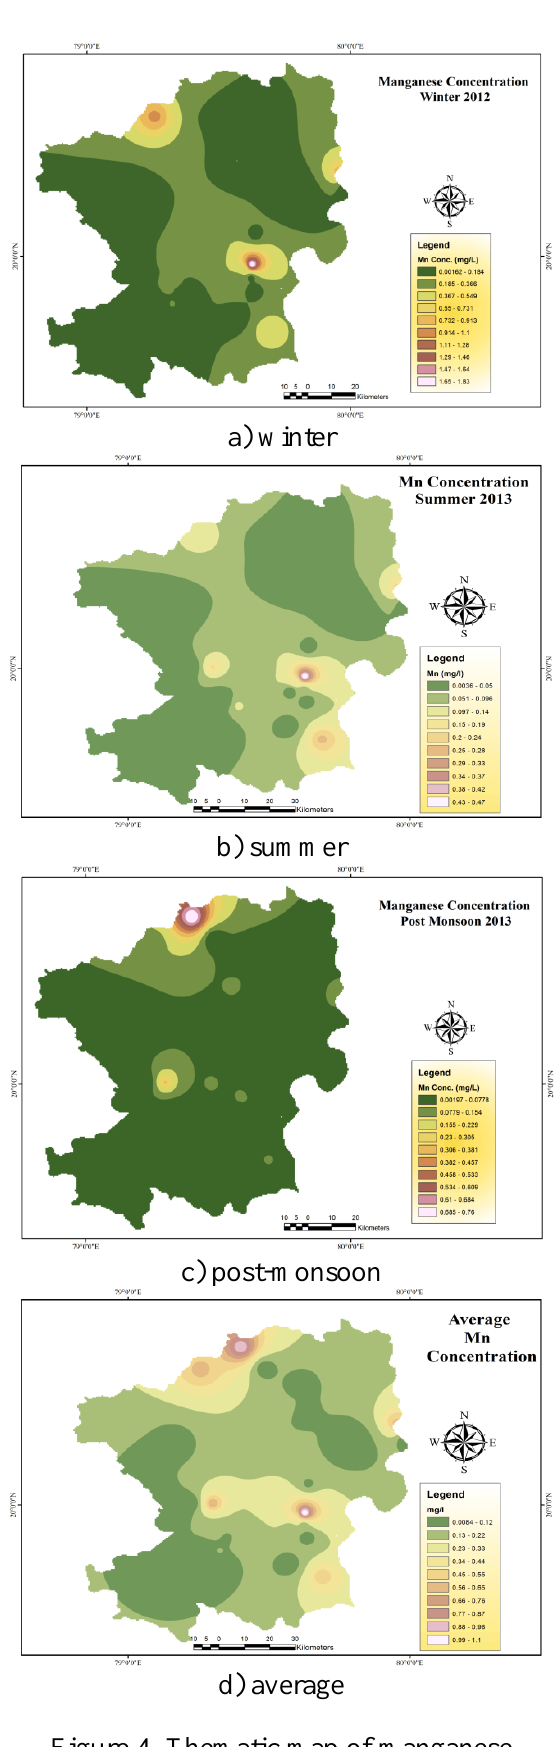
Figure 4. Thematic map of